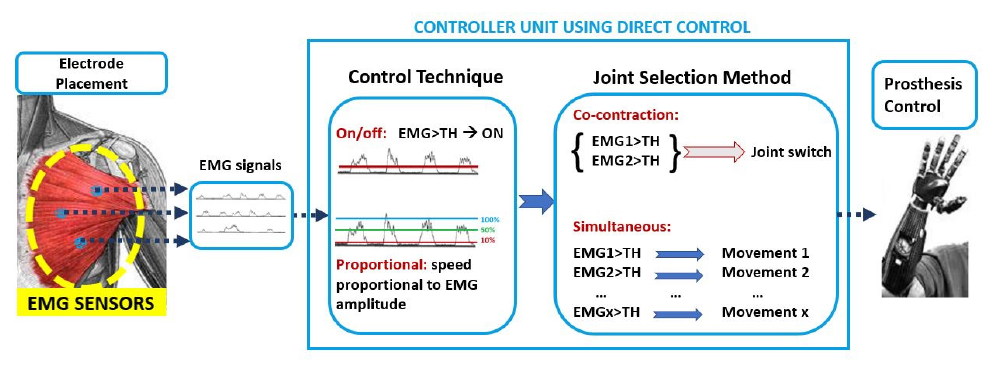
Figure 5. Direct Control approach: the EMG signals are the input to the controller unit. Two control techniques (the on/off and the proportional) defined the speed necessary to move the joint when the EMG signal is above a predefined threshold. The joint selection methods allow for the user to switch joints with muscle co-contraction or to select them simultaneously.